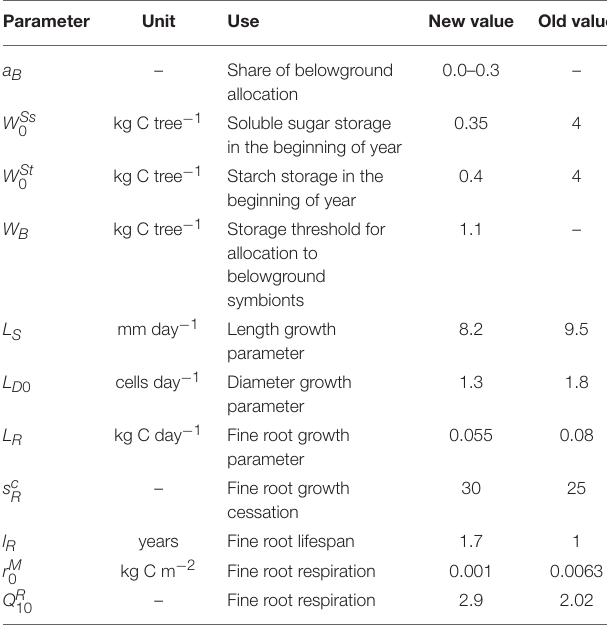
TABLE 3 | New or adjusted parameters compared with Schiestl-Aalto et al.